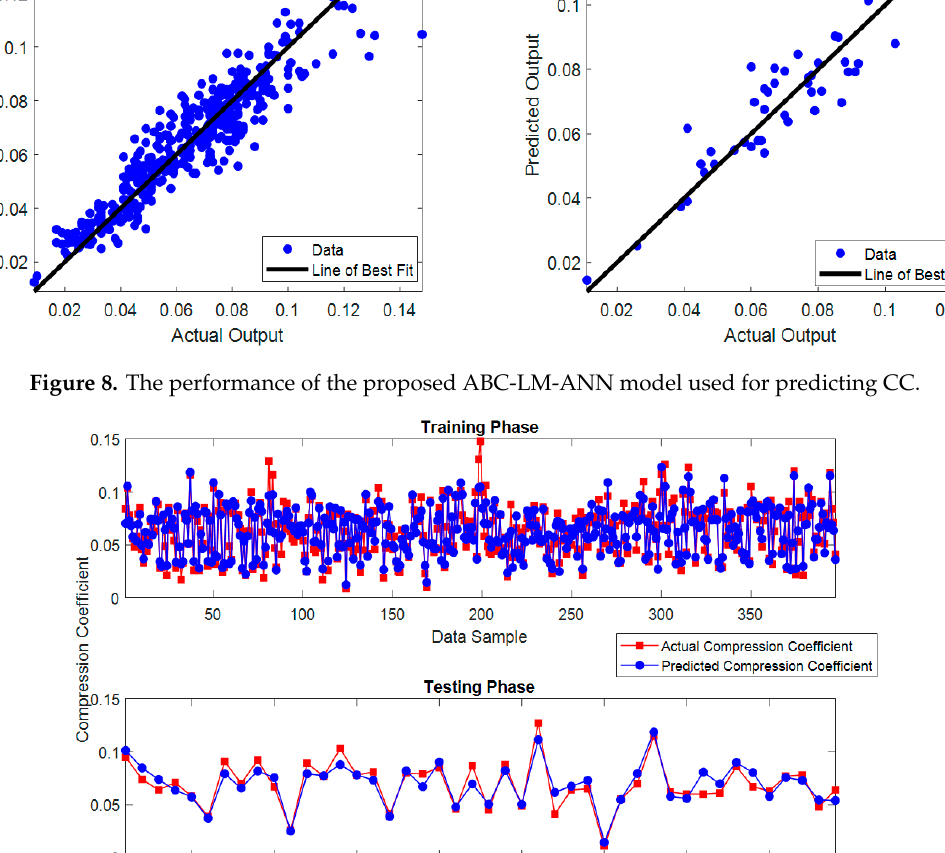
Figure 9. The actual CC vs. the value of CC predicted by the proposed ABC-LM-ANN model.